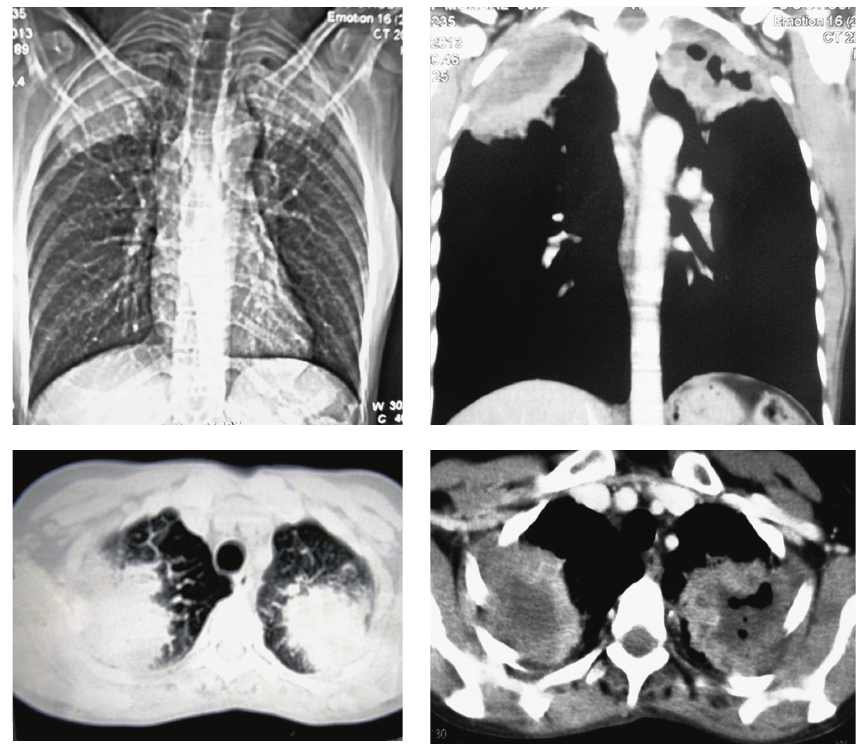
Figure 2: CECT thorax showing heterogeneous, pleural based lung masses in upper lobes of both sides.